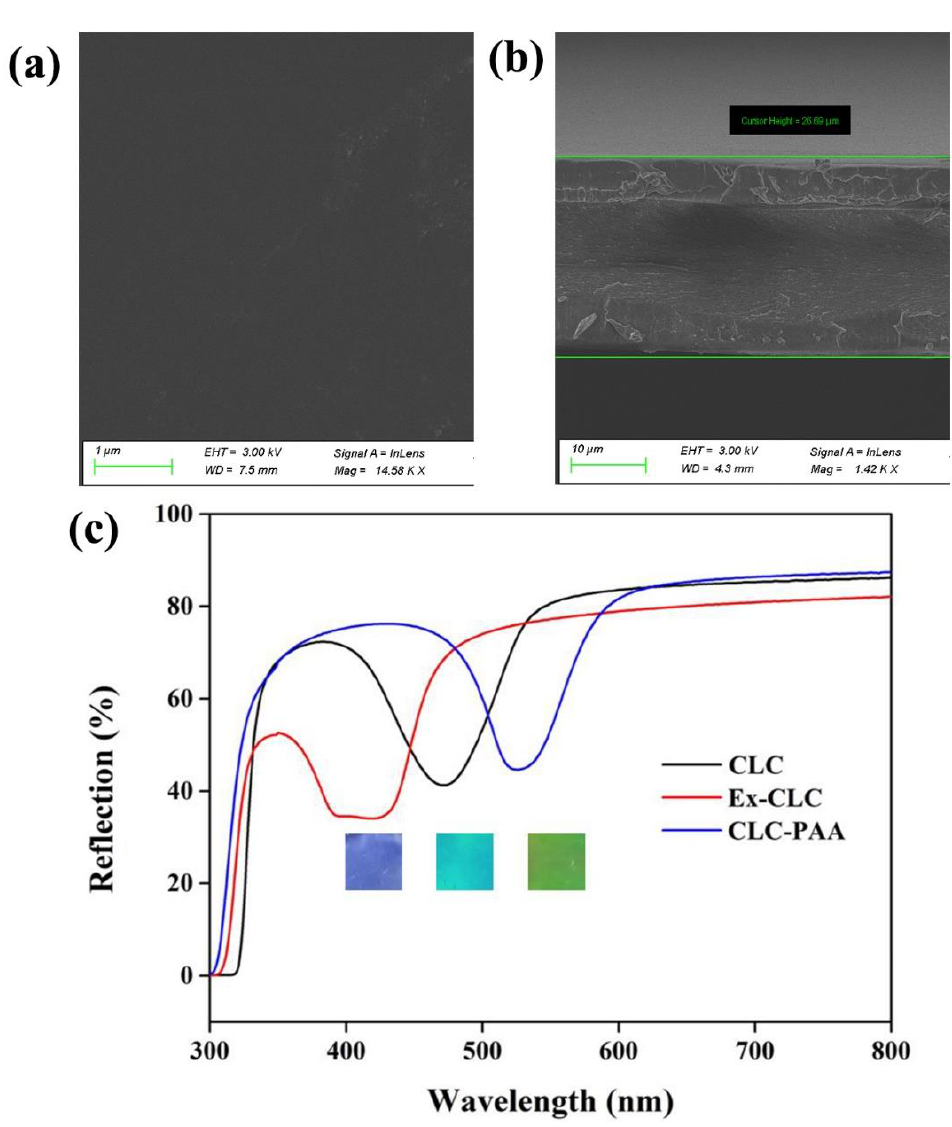
Figure 4. SEM images of ( a ) fractured surface and ( b ) the upper surface of prepared CLC PC films. ( c ) UV – vis spectra and the optical photographs of Ex-CLC, CLC PC and CLC-PAA PC film.